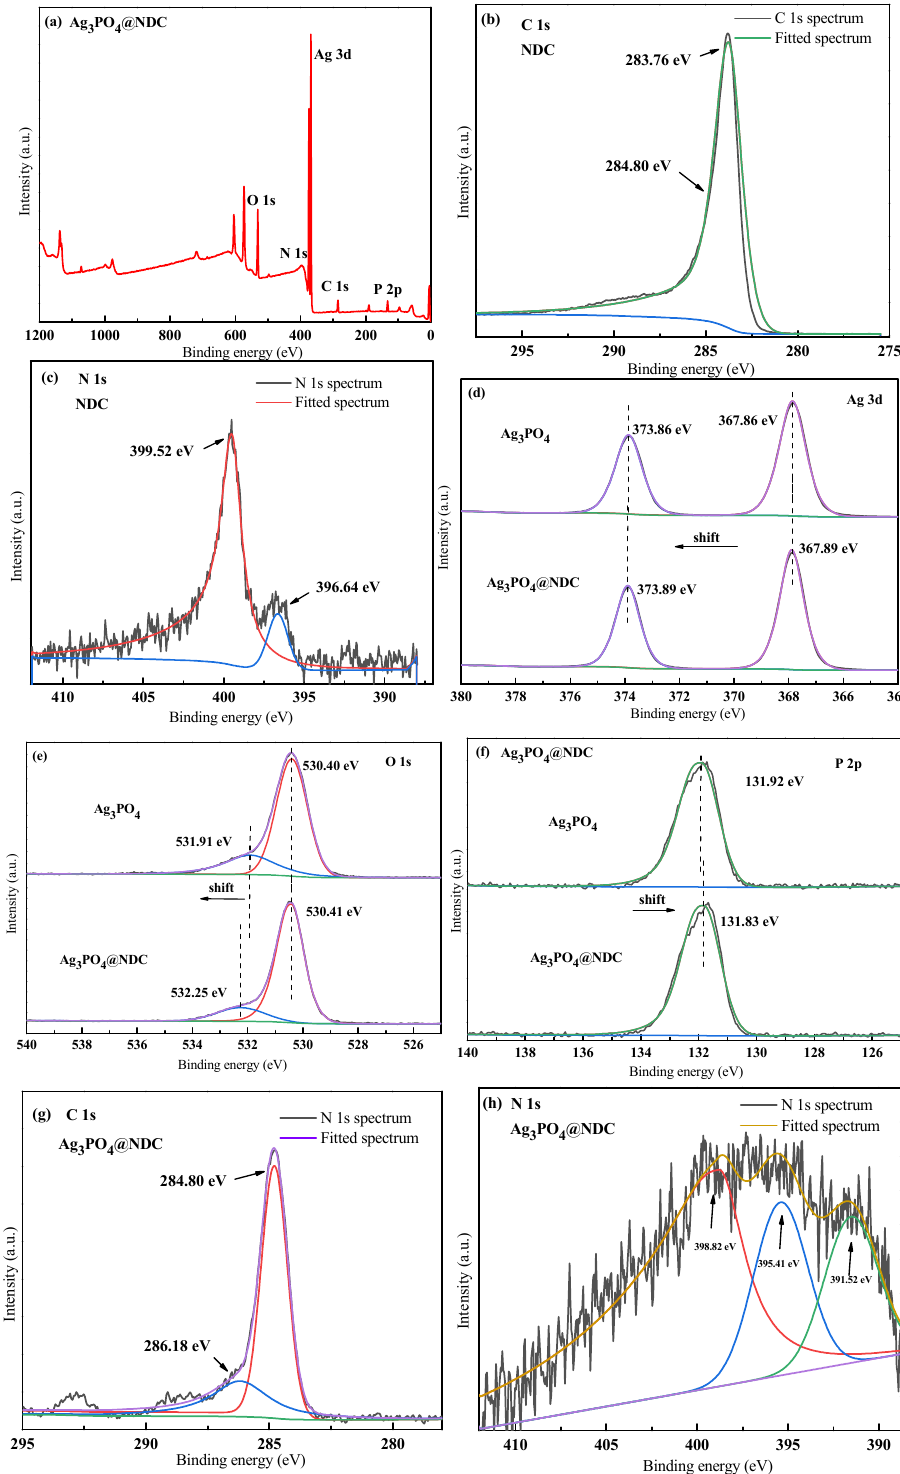
Figure 6. ( a ) XPS survey spectra of Ag 3 PO 4 @NDC; high-resolution XPS spectrum of NDC: ( b ) C 1s and ( c ) N 1s; high-resolution XPS spectrum of NDC and Ag 3 PO 4 @NDC: ( d ) Ag 3d, ( e ) O 1s, ( f ) P 2p; high-resolution XPS spectrum of Ag 3 PO 4 @NDC: ( g ) C 1s and ( h ) N 1s.